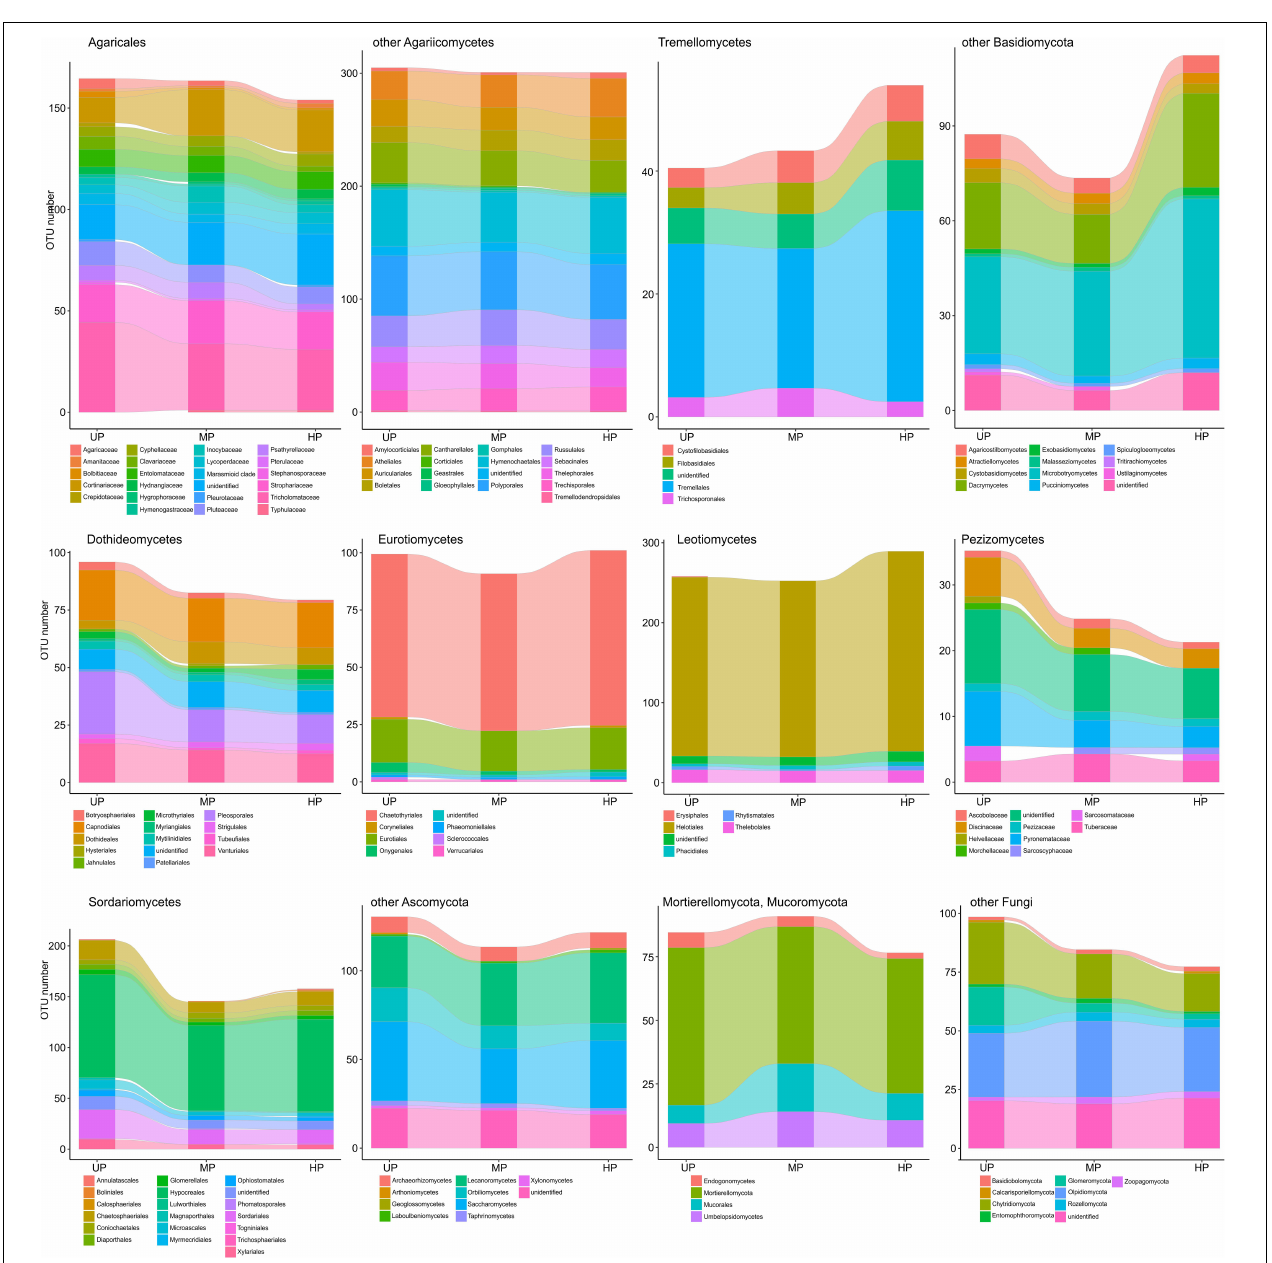
FIGURE 7 | Total OTU number of fungal taxa in the wood from unpolluted (UP), moderately polluted (MP), and heavily polluted (HP) areas ( n = 29 samples per area). OTU, operational taxonomic unit.